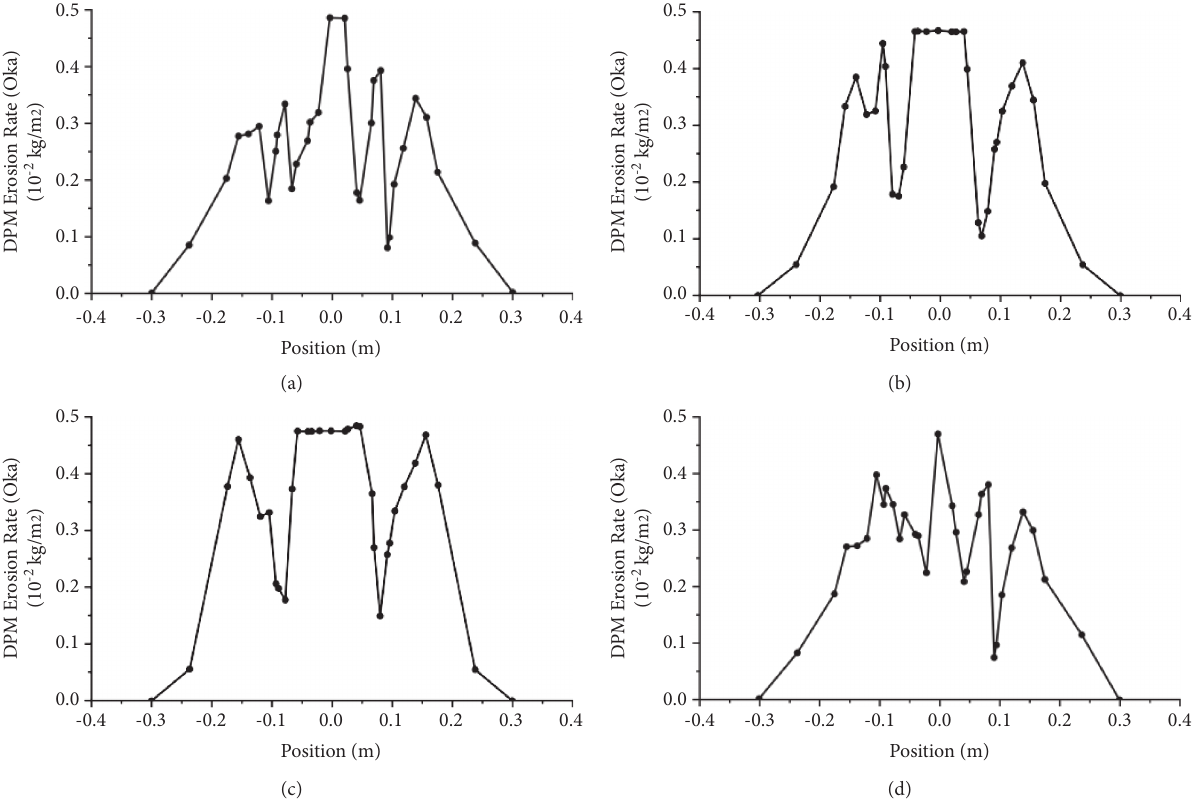
Figure 8: The erosion curve of the transverse blade surface with different blasting pressures. (a) The erosion curve of the transverse blade surface with the blasting pressure of 0.5MPa. (b) The erosion curve of the transverse blade surface with the blasting pressure of 0.6MPa. (c) The erosion curve of the transverse blade surface with the blasting pressure of 0.7 MPa. (d) The erosion curve of the transverse blade surface with the blasting pressure of 0.8MPa.